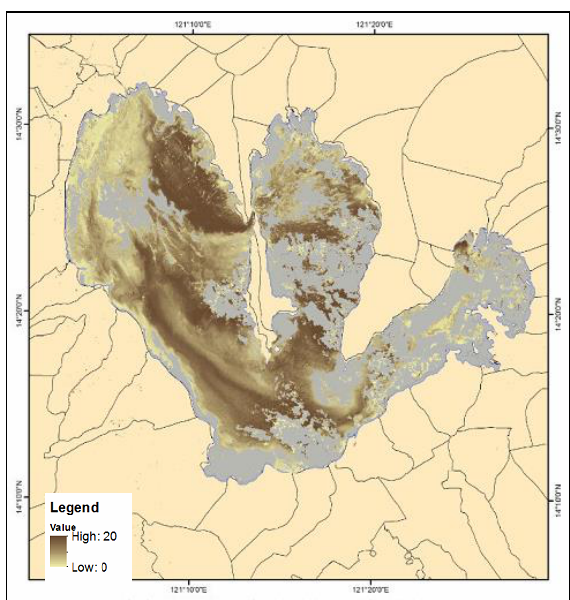
Figure 10. BOMBER tool derived SPM Map of Oct 16,